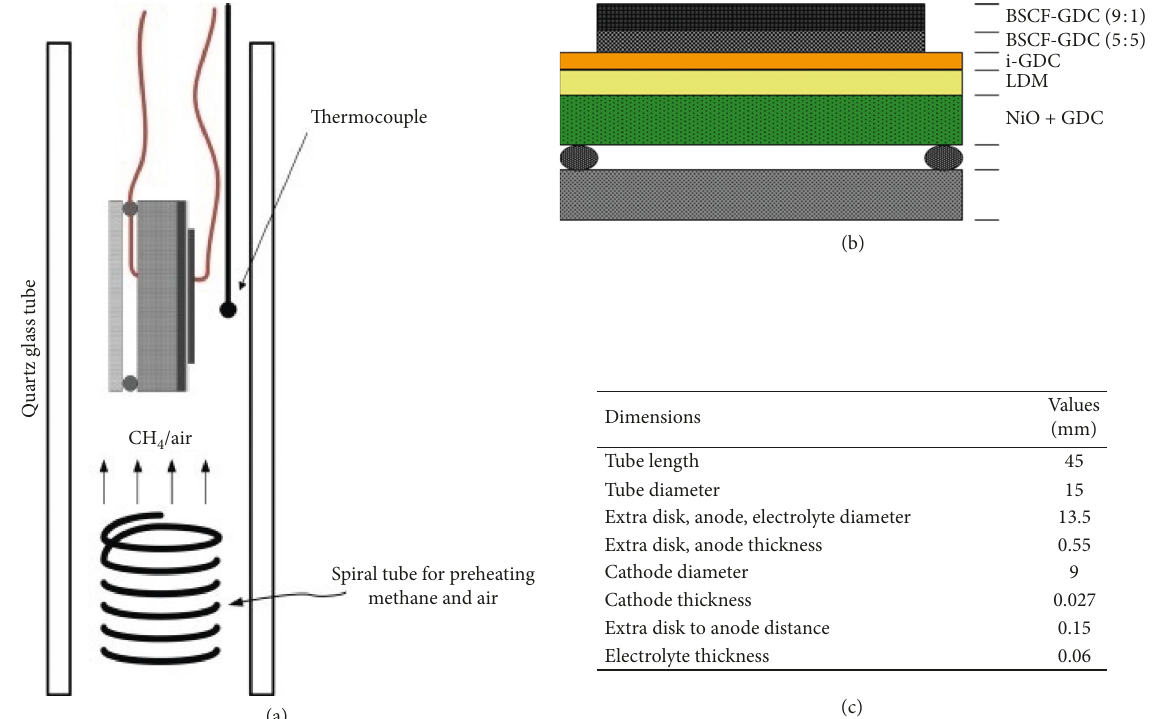
Figure 1: (a) Configurations of single-chamber solid oxide fuel cells (SOFCs) and the detail of anode-supported cell [37]. (b) A sketch of the button cell. (c) Geometry dimensions of the experimental